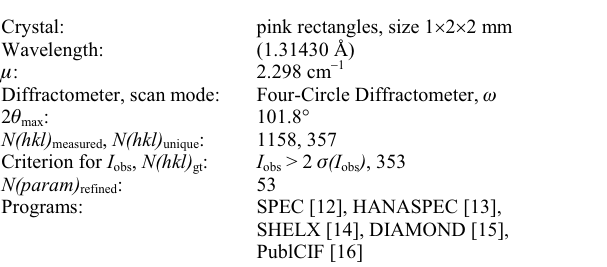
Table 1. Data collection and